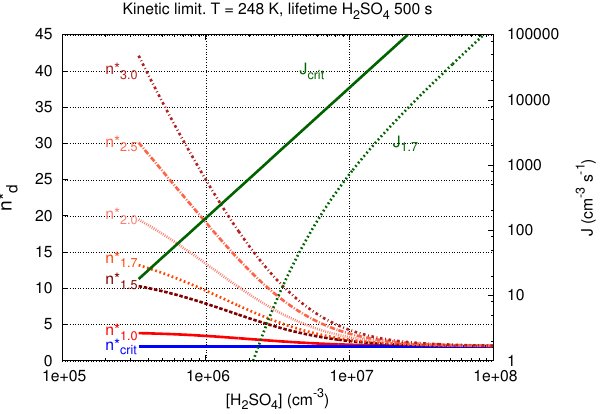
Fig. 4. n ∗ vs. wall loss rate coefficient k w for [ H 2 SO 4 ] = 2 . 3 × d 10 6 cm − 3 and no evaporation of nucleating particles. Labels are the same as in Fig.